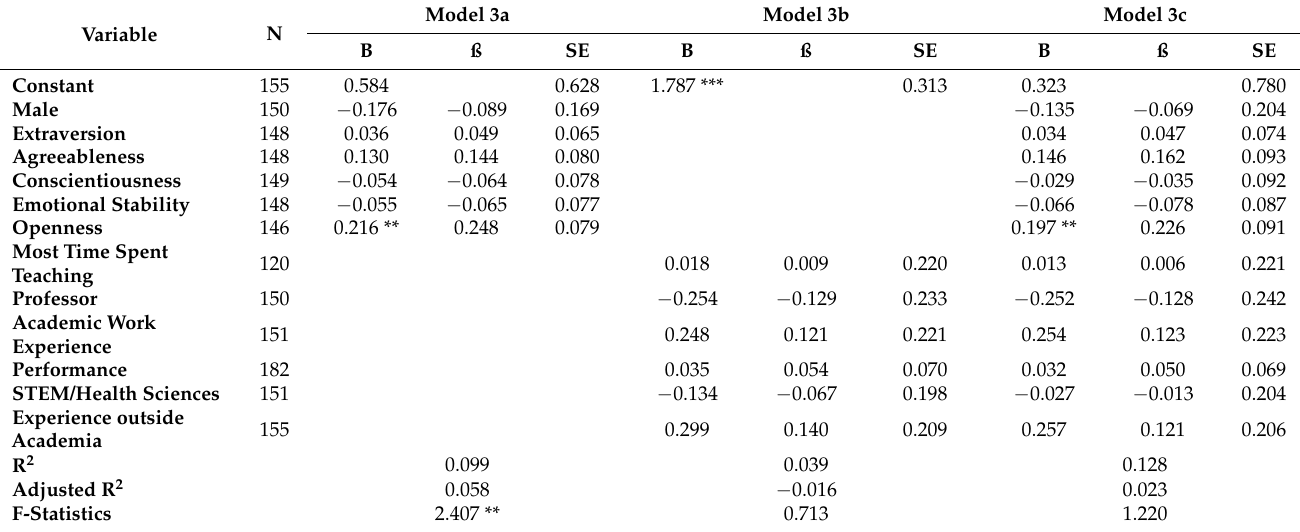
Table A3. Multiple regression models predicting engagement in external teaching and training